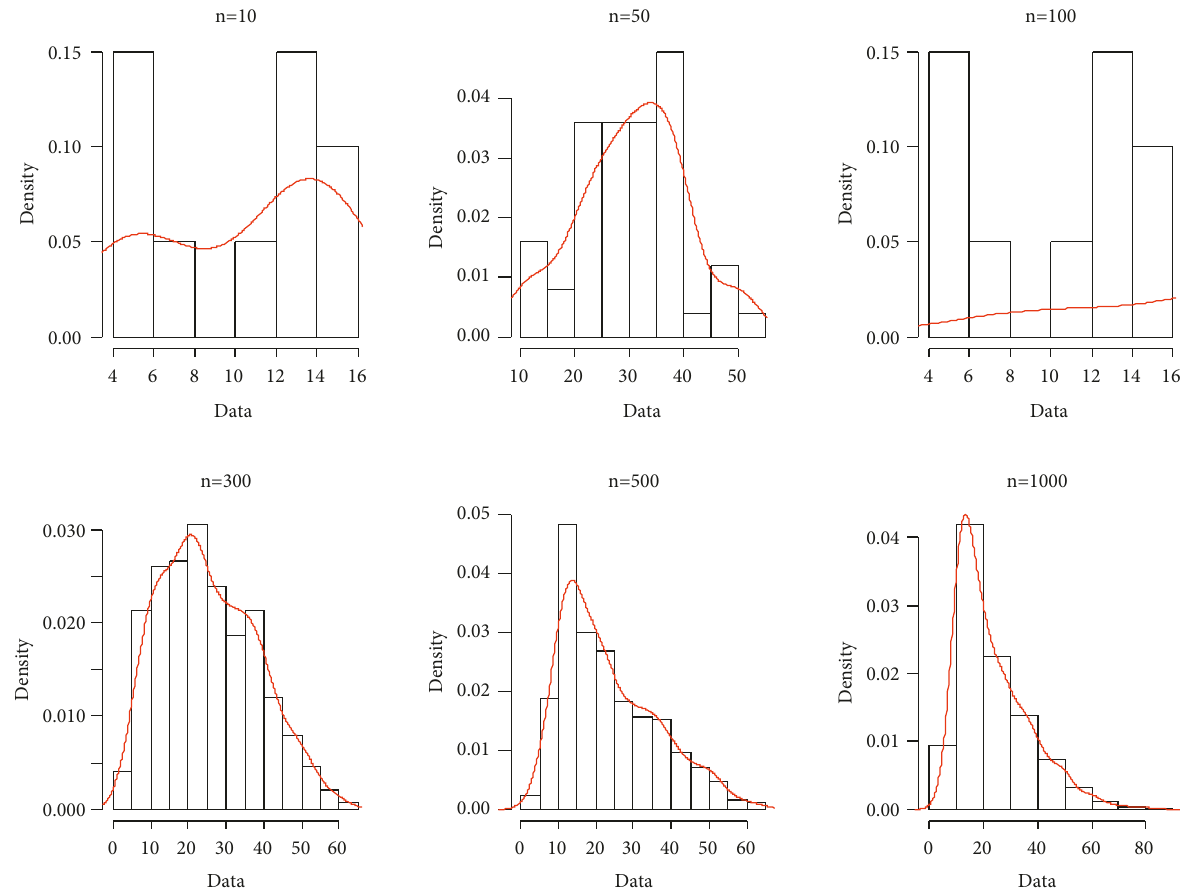
Figure 9: The density of daily PM 2.5 in the six sample